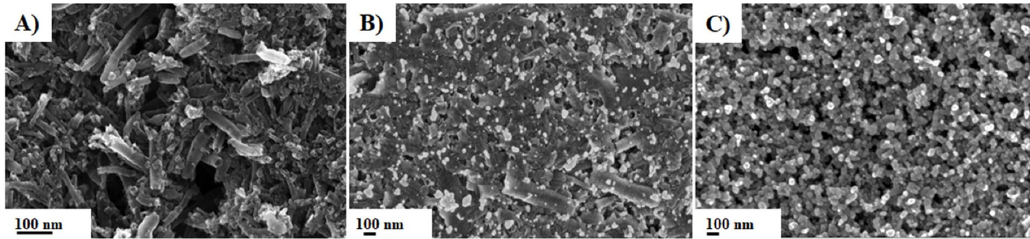
Figure 2. SEM micrographs for ( A ) Bare ‐ carbon ‐ nanofiber ‐ based screen ‐ printed electrodes (SPCNFEs) and electrodes modified by drop ‐ casting: ( B ) Ag ‐ NS ‐ SPCNFE and ( C ) Ag ‐ NPr ‐ SPCNFE (800 μ